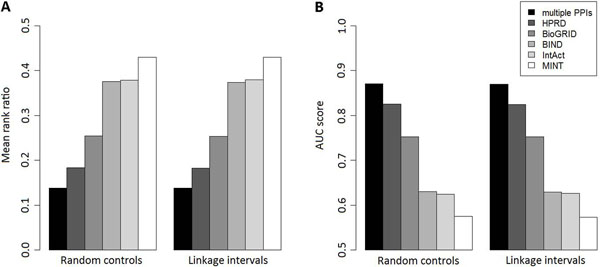
Performance of the integration method. Subplot A illustrates mean rank ratios for the integration method and individual PPI networks. Subplot B illustrates AUC scores for the integration method and individual PPI networks. Results for the validation of random controls are average of 10 independent runs (variance not shown).